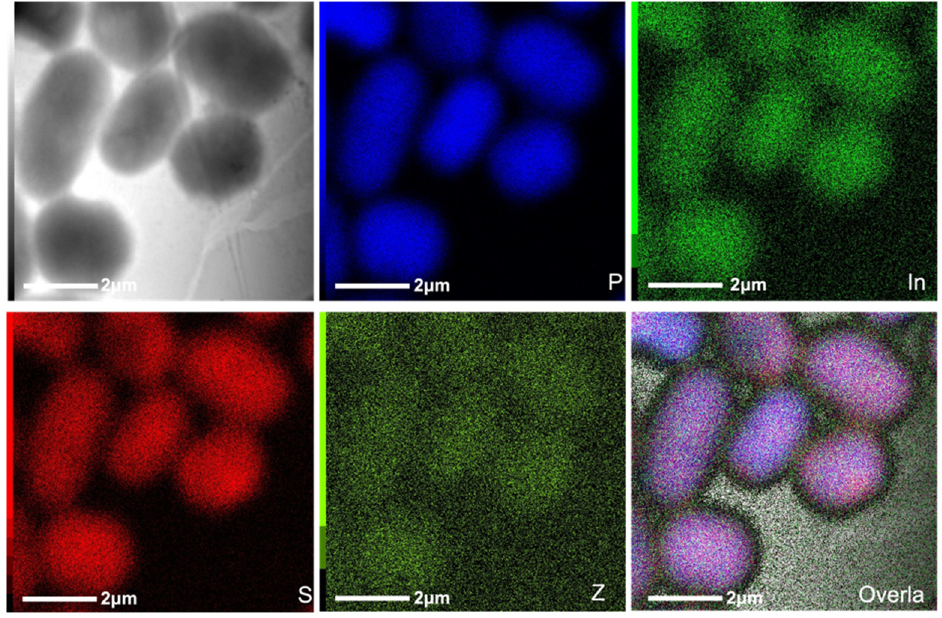
Figure 6. Scanning transmission electron microscopy (STEM) images of AB9 targeted with aptamer- QDs and stained with uranyl acetate with an elemental map for phosphorous (blue), sulphur (red), indium (bright green) and zinc (dark green). Scale-bar 2 μ m.